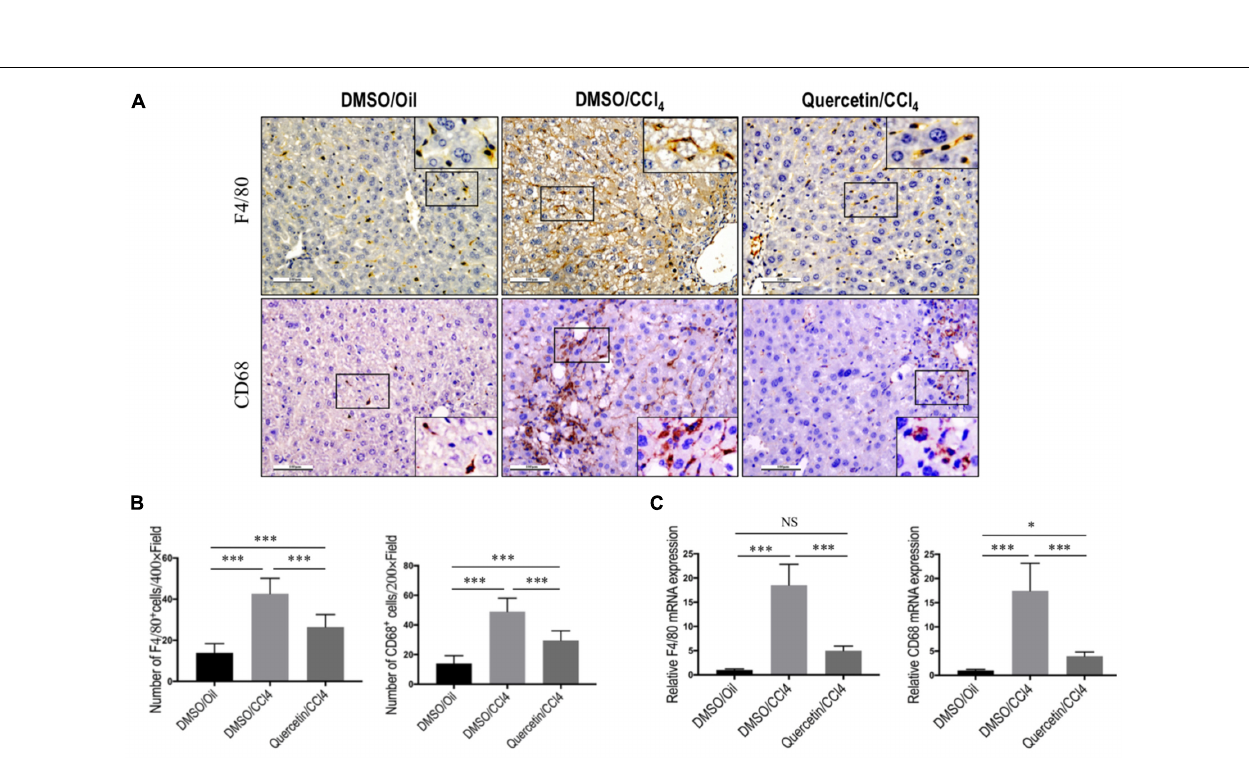
FIGURE 4 | Quercetin inhibited massive macrophage recruitment into the fibrotic livers of CCl 4 -induced mice. (A) Immunohistochemical detection of F4/80- and CD68-positive cells in liver sections from each group (original magnification: × 200). Insert (magnification: × 400) shows typical morphology of positive macrophages. Scale bar = 100 µ m. (B) Quantification of F4/80- and CD68-positive cells in liver sections. Results mean of six fields and n = 5/group. (C) Gene expression of macrophage marker F4/80 and CD68 was determined in livers by quantitative RT-PCR, and the results are shown as fold change compared with sham-treated control and GAPDH served as loading control ( n = 6). ∗ P < 0.05; ∗∗∗ P < 0.001; “NS” indicates not significant.